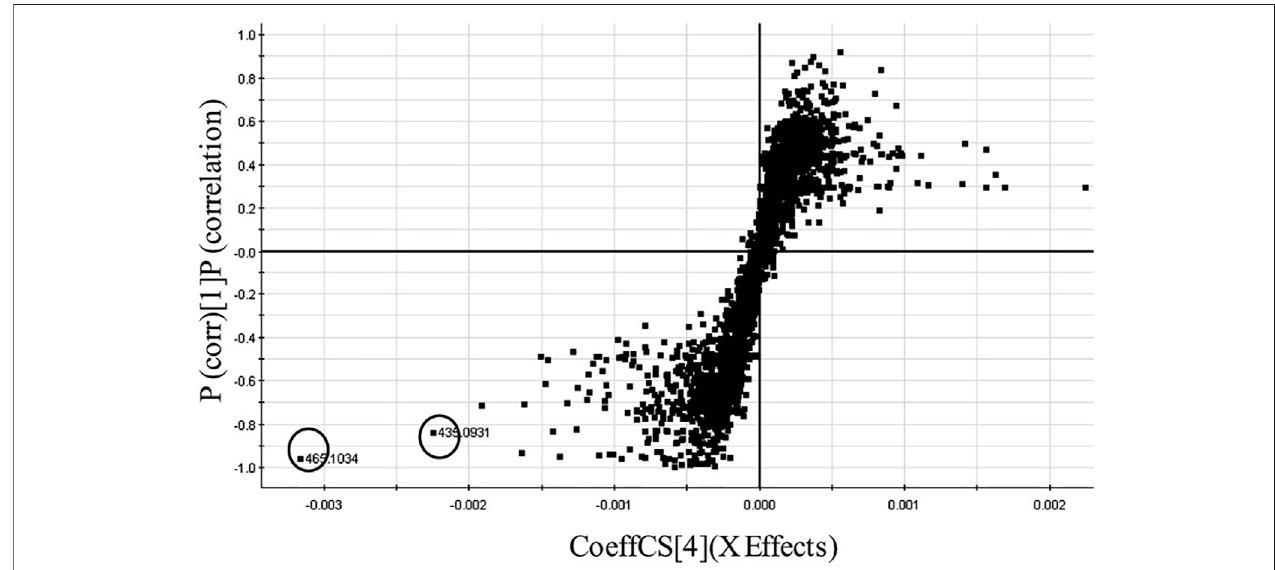
FIGURE5| S-plotofactiveversusinactiveCreeplantsleadingoftwosigni fi cantbiomarkers(circled)ofinhibitionofglucoseuptake,quercetin3-O-arabinosideand quercetin 3-O-galactoside. Figure appears as inset of Figure originally published in Shang et al. (2015). Novel approach to identify potential bioactive plant metabolites: pharmacological and metabolomics analyses of ethanol and hot water extracts of several Canadian medicinal plants of the Cree of Eeyou Istchee, PLoS One, 2015, 10(8), e0135721. Reproduced from Ref. 19, under the terms of a CC BY 4.0 license